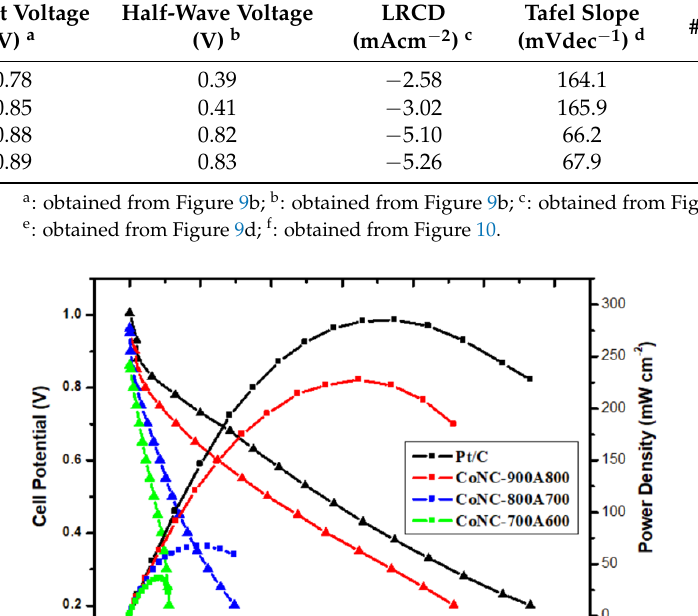
Figure 9. ( a ) C – V curve of CoNC − 1000A900 conducted in O 2 and N 2 saturated, 0.1 M KOH (aq) , ( b ) LSV curves obtained at 1600 rpm in O 2 -saturated, 0.1 M KOH (aq) , ( c ) Tafel slopes of various Co – N – C catalysts, and ( d ) e-transferred values of various Co – N – C cathode catalysts. Table 4. Comparison of various electrochemical properties of Co – N – C catalysts.